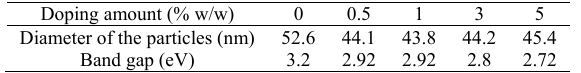
nanoparticles 2